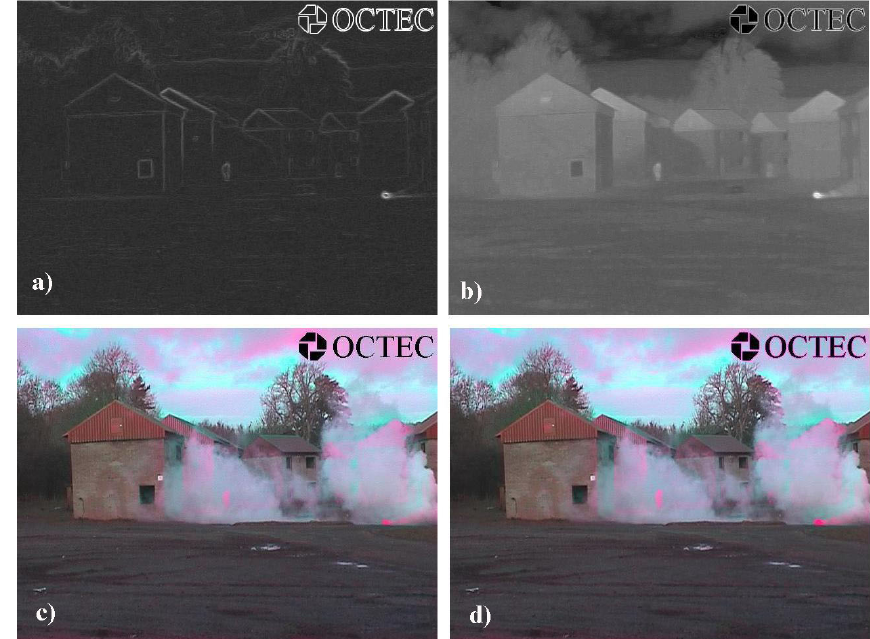
Figure 11 – Structure enhanced color fusion: a) gradient magnitude of the IR image in Figure 3b, b) enhanced IR image I’, c) and d) images fused using the proposed method without and with structural enhancement Opravdanost predložene metode potvr đ ena je i na sekvencama